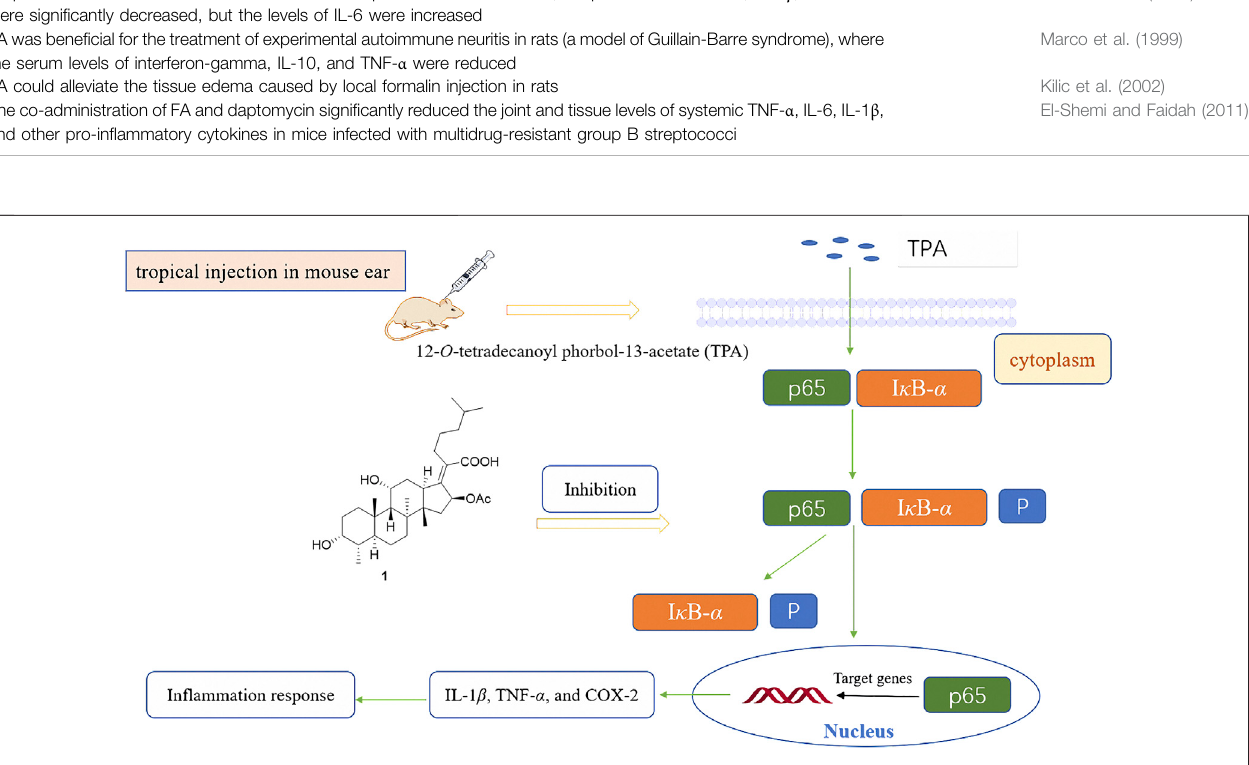
FIGURE 10 | Schematic representation of the anti-in fl ammation mechanism of compound 1 in TPA-induced mouse ear edema models.